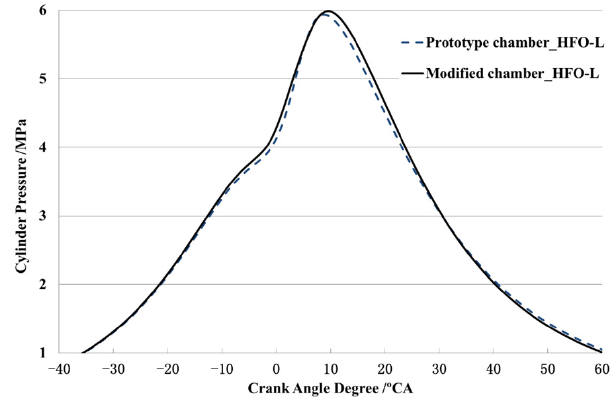
Figure 8. The comparison of cylinder pressure curves between the prototype and modified combustion